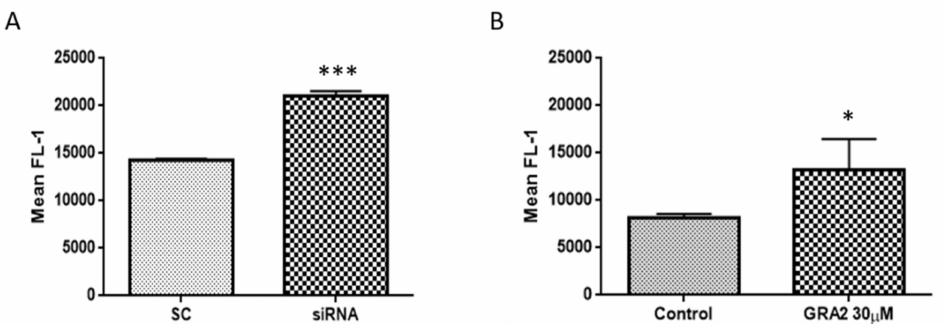
Figure 5. GPR21 inhibition improves GLUT-2 translocation to the plasma membrane. Flow cytometry analysis of GLUT-2 expression at the cell membrane of HepG2 cells transfected with non-silencing siRNA (SC) or with specific Scheme 21. (siRNA, ( A )) or exposed to GRA2 (30 µ M, 24 h, panel ( B )). Data are expressed as the mean of fluorescence FL-1 ± SEM; n = 4. * p < 0.05 vs. control; *** p < 0.001 vs. scramble control